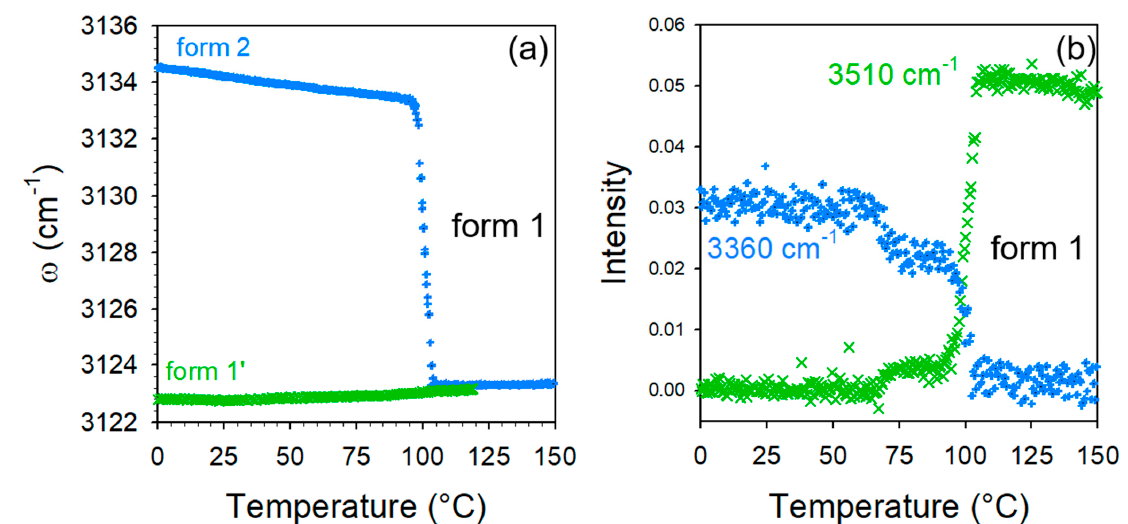
Figure 7. Data analysis of the high-frequency spectra of the co-crystal forms 1 ′ and 2; ( a ) temperature dependence of the C–H stretching band distinctive of forms 1 ′ and 2; ( b ) Integrated intensity of the O–H stretching bands distinctive of molecular associations in the co-crystal form 1 ′ (3510 cm − 1 ) and in the co-crystal hydrate form 2 (3360 cm − 1 ), measured upon heating form 2.